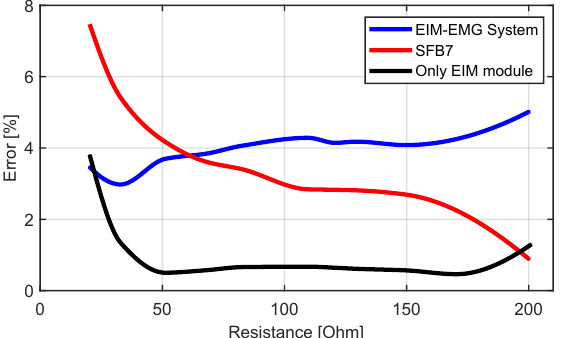
Figure 11. Percentage error of EIM module (black), EIM-EMG system (blue), and SFB7 (red) error respect to multimeter while measuring pure known resistances.